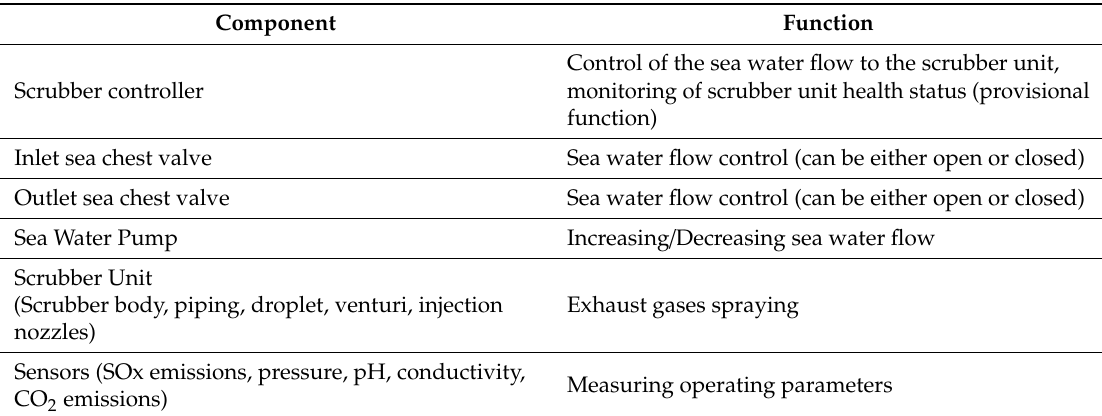
Table 3. Exhaust gas open loop scrubber system main components and their functions.